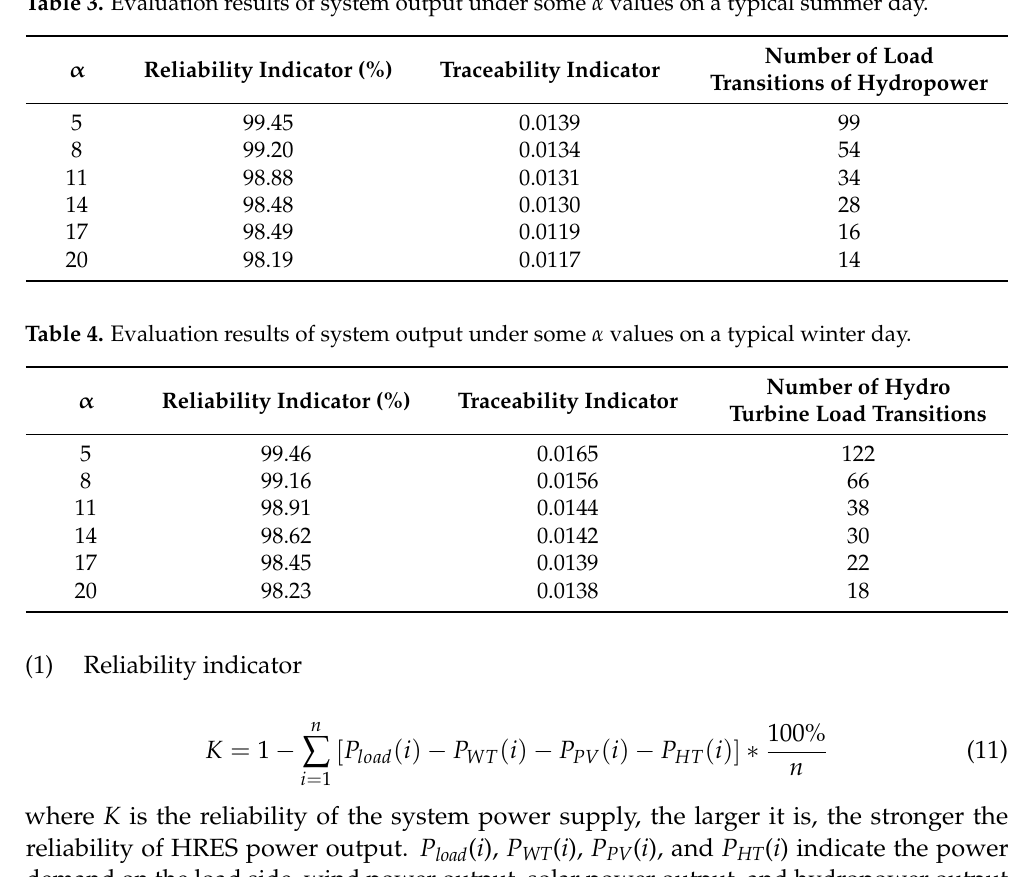
Table 3. Evaluation results of system output under some α values on a typical summer day.